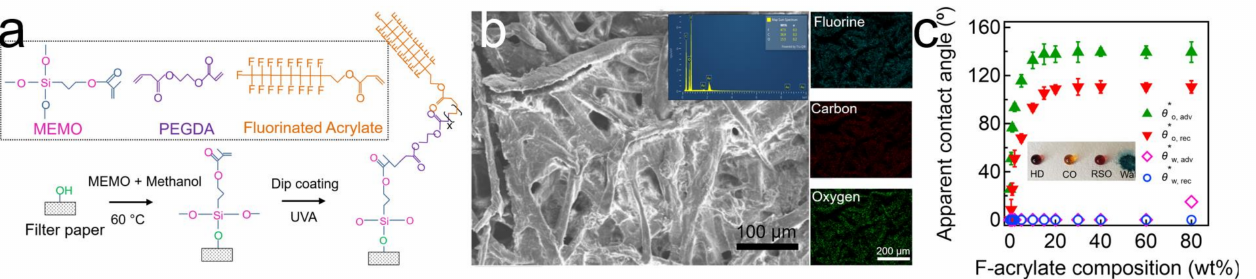
Figure 1. ( a ) Schematic demonstrating the grafting of the filter surface with MEMO and the subsequent coating with F-PEGDA. ( b ) SEM image showing the morphology of the filter after coating with F-PEGDA (20 wt.%). Inset shows the elemental EDS spectrum and the elemental mappings for fluorine. ( c ) The measured apparent advancing and receding contact angles of water and oil (n-hexadecane) on the F-PEGDA-coated filter surface with varied compositions of F-acrylate. A filter with a 6.0 µ m inherent nominal pore size was